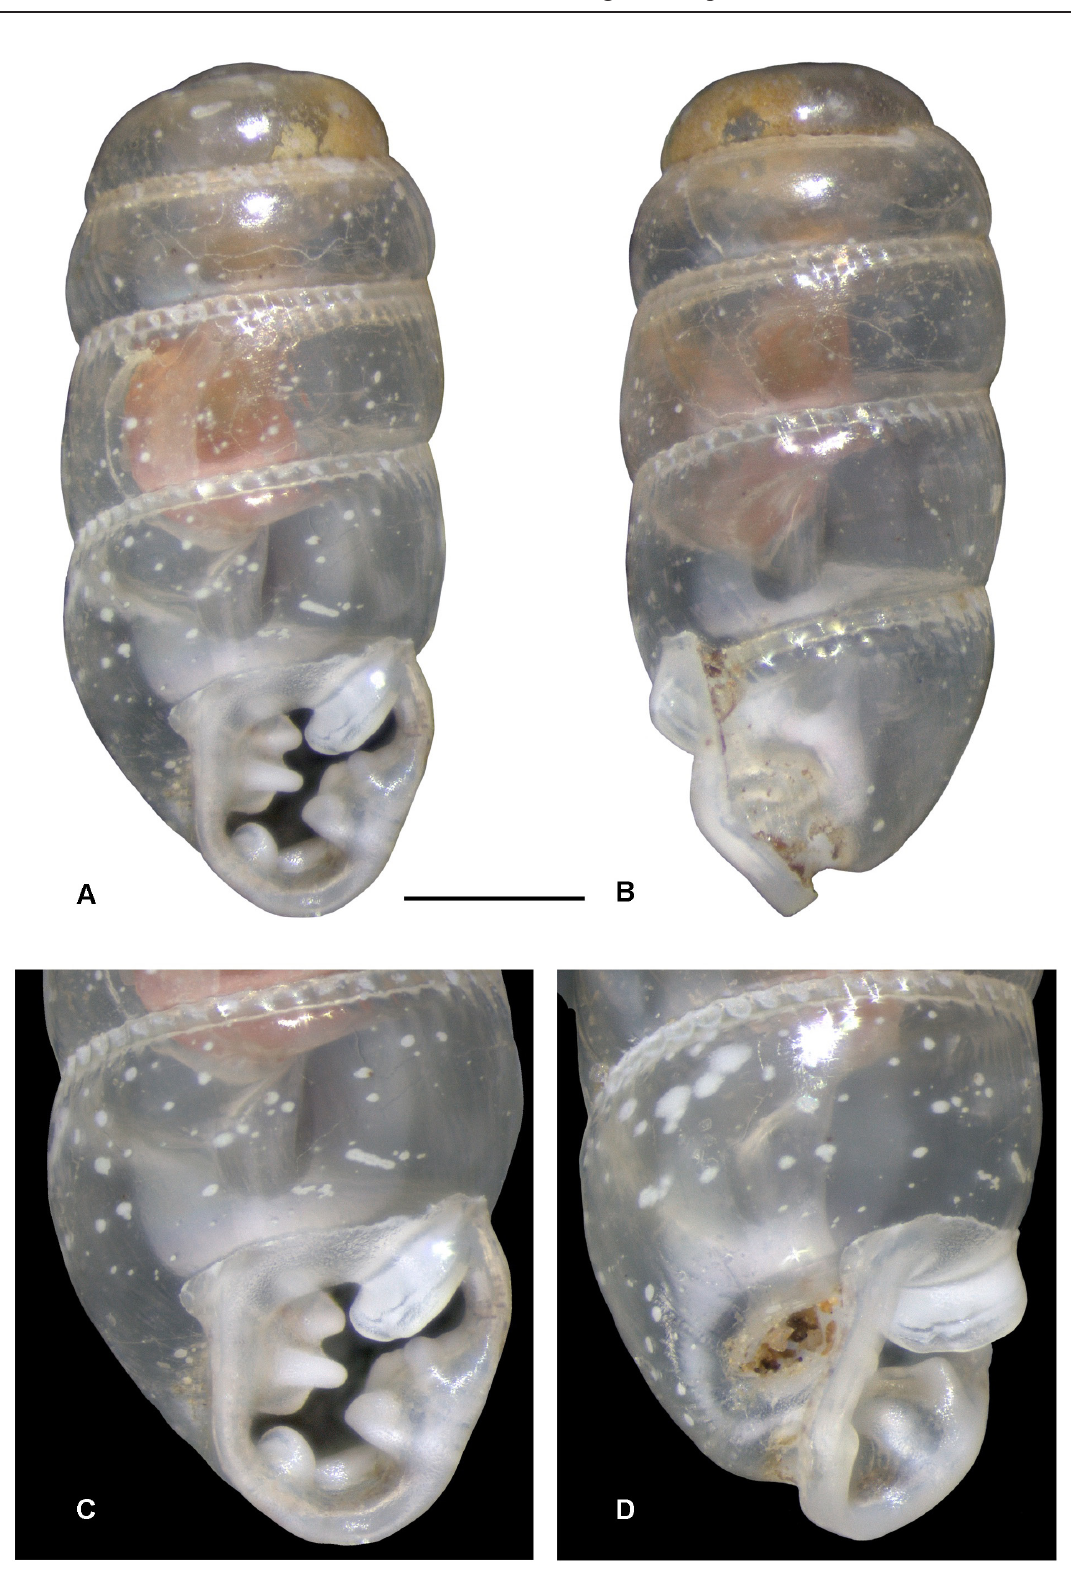
Fig. 3 . Gulella fordycei sp. nov., holotype (NMSA P1679/T4525), length 2.34 mm, width 1.06 mm. A . Aperture view. B . Side view. C . Oblique view into aperture. D . Oblique view of base showing umbilicus. Scale bar = 0.5